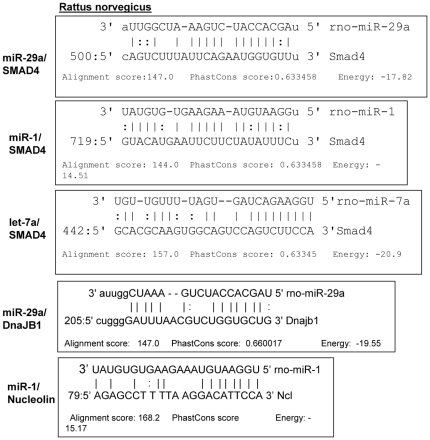
SMAD4, is one of the targets for miR-29a and/or miR-23a: Bioinformatics analysis.miR-1, miR-29a and miR-23a for SMAD4, DnaJ-B1 and nucleolin 3′UTRs. MIRANDA and Sloan-Kettering MicroRNA target analysis site were used for this analysis. Alignment score, PhastCons score and Energy values were cited for all the interactions.